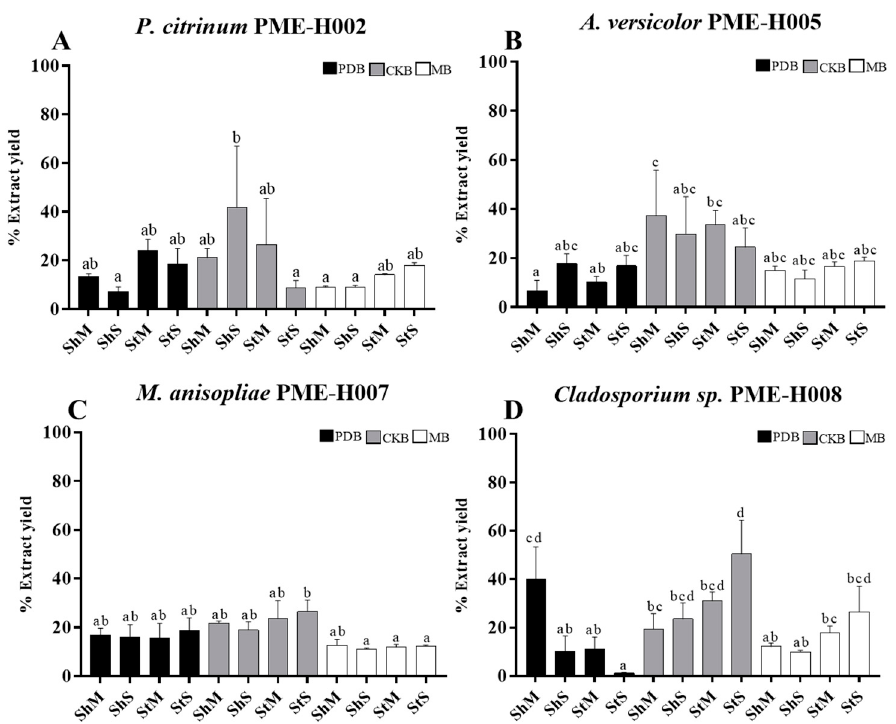
Figure 1. Yield of methanol extracts from endophytic fungal strains under different culture con- ditions. ( A ) P. citrinum PME-H002. ( B ). A. versicolor PME-H005. ( C ) M. anisopliae